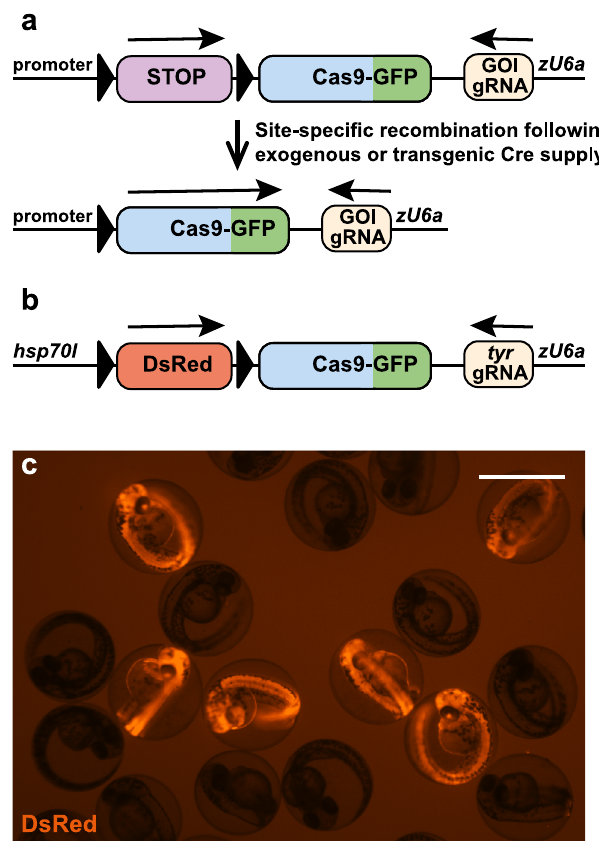
Fig. 1 Cre-Controlled CRISPR (3C) mutagenesis allows gene